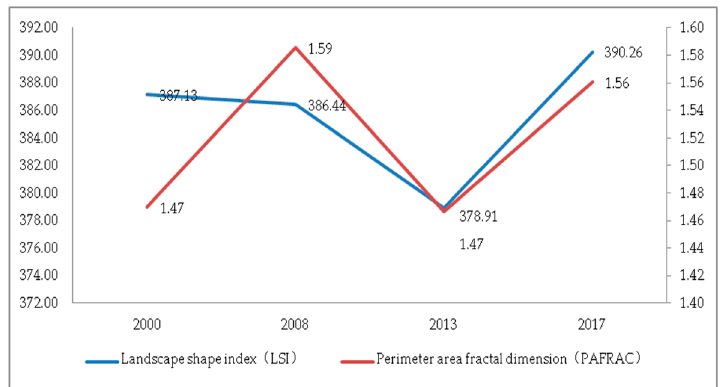
Figure 13. The LSI and perimeter - area fractal dimension (PAFRAC) at the landscape level.